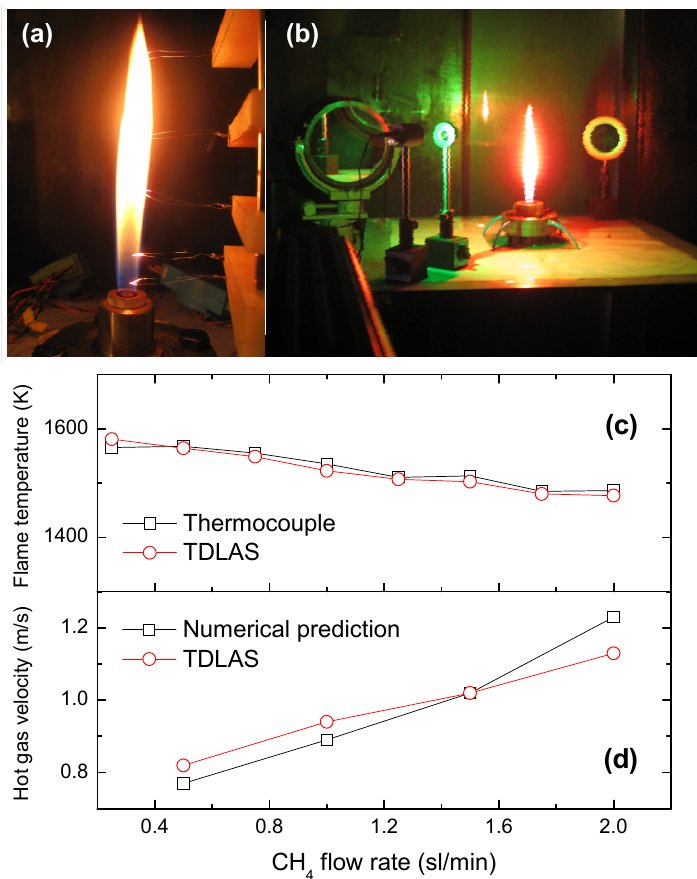
Figure 10. CH 4 /air flame data acquired using ( a ) thin Pt-Rh thermocouples, ( b ) the TDLAS system, and validations of the ( c ) flame temperature and ( d ) velocity and validations of the ( c ) flame temperature and ( d ) velocity results.